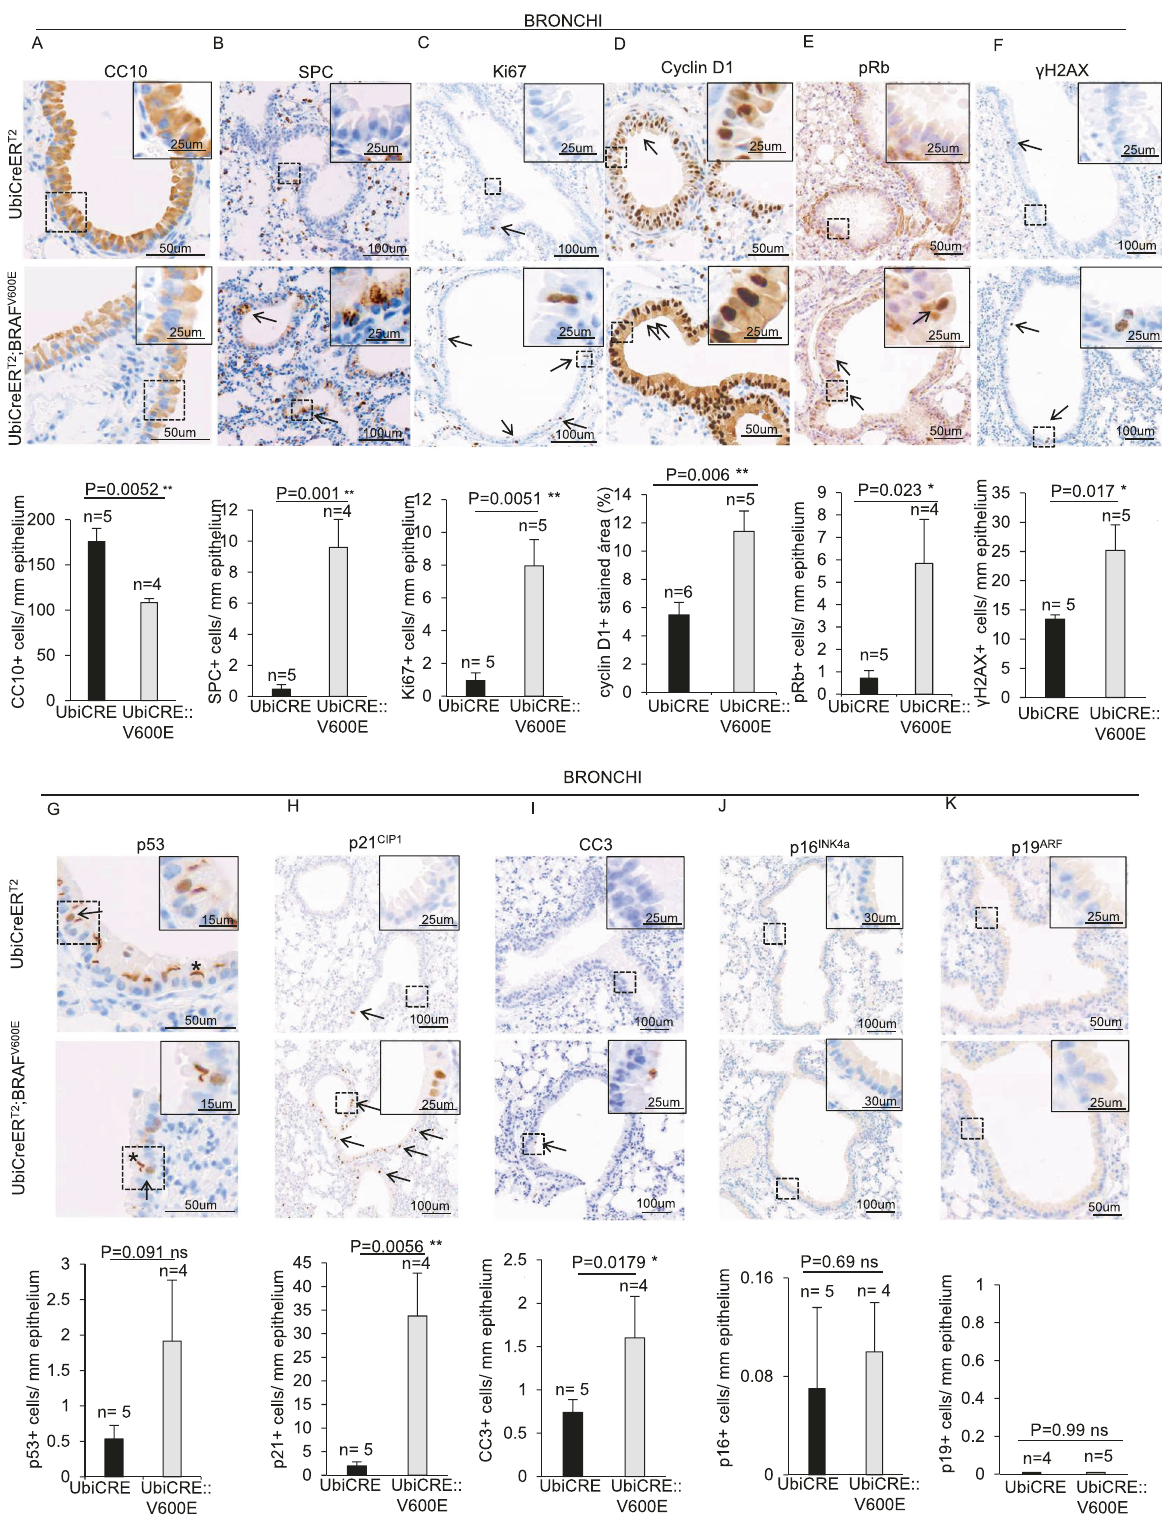
Fig. 5 Analysis of the early molecular response of BRAF V600E induction in bronchial/bronchiolar epithelium. A – K Representative images (top) and quanti fi cations (bottom) showing bronchial/bronchiolar epithelial cells staining positive for A CC10, B SPC, C Ki67, D cyclin D1, E pRb, F γ H2AX, G p53, H p21 CIP1 , I CC3, J p16 INK4a , K p19 ARF immunostainings in lung sections from BRAF V600E and control mice. Quanti fi cations were performed on at least fi ve different areas of the lung sections in a random way. Data are expressed as mean ± SEM; n = animals per group. * P < 0.05; ** P < 0.01; *** P < 0.001, ns = not signi fi cant. (T Student ’ s test unpaired). Arrows point to selected positive cells for the indicated marker. Insets: magni fi cations of areas inside dashed squares. Asterisks in G indicate an unspeci fi c signal of the